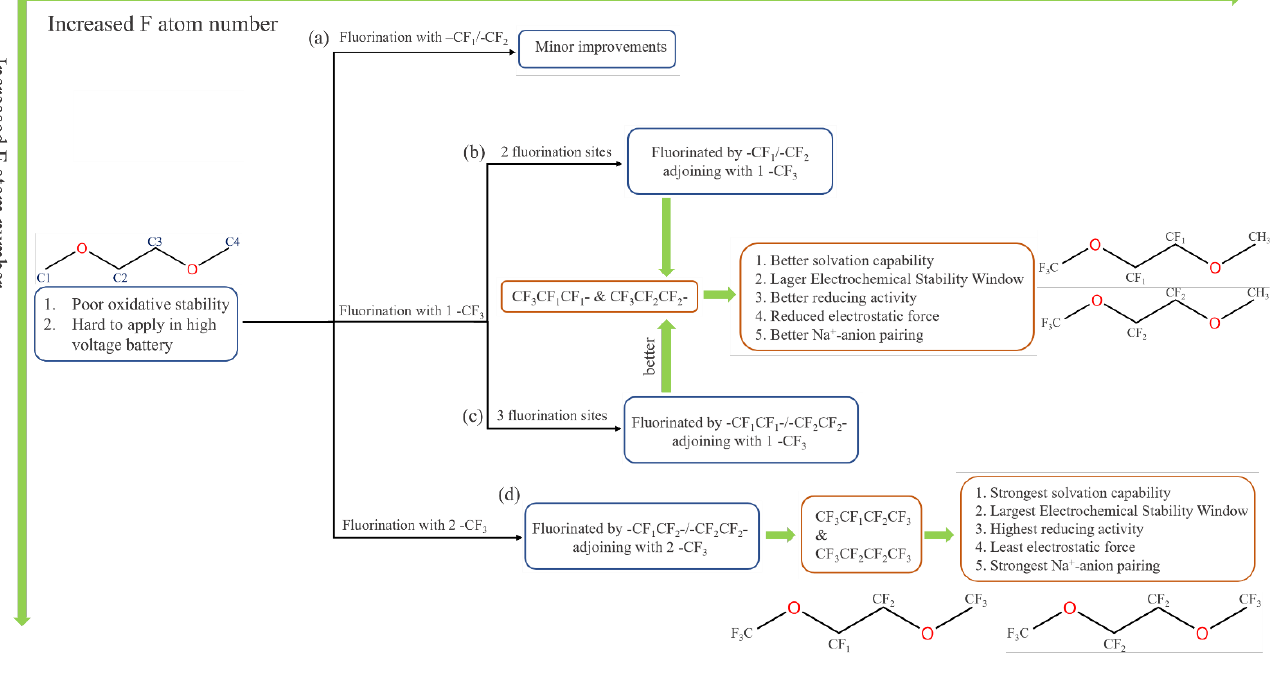
Figure 6. Fluorination logic flow. Fluorination with -CF 1 /-CF 2 ( a ), fluorination with two fluorination sites ( b ), fluorination with three fluorination sites ( c ), fluorination with two -CF 3 ( d ).